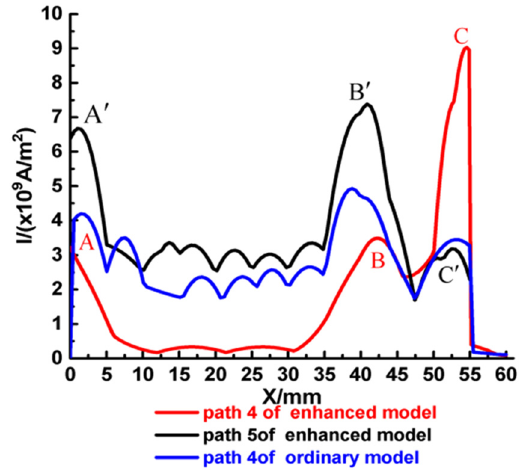
Figure 11: Current distribution the cross - section